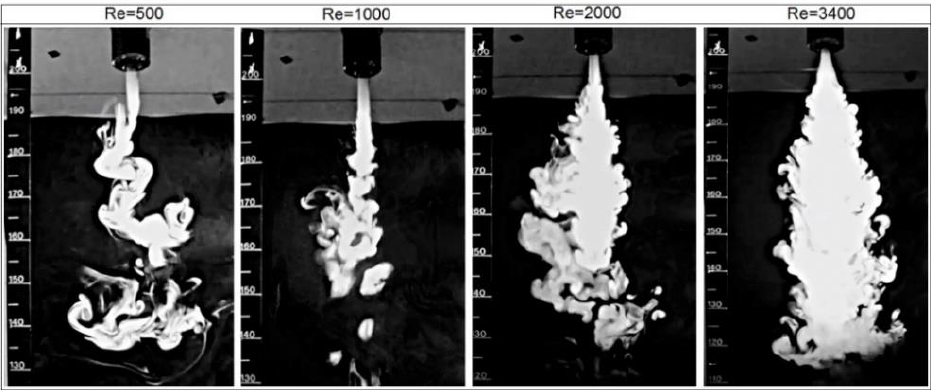
Figure 2. Jet development at different initial conditions.